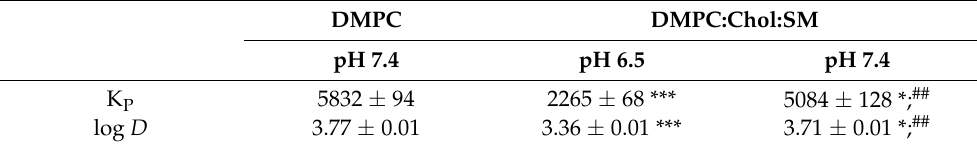
Figure 1. Steps for calculating the LUVs–buffer partition coefficient of BTZ. ( A ) UV–Vis spectra and ( B ) third-derivative spectra of BTZ (400 µ M) at increasing concentrations of DMPC:Chol:LUVs at 37 ◦ C and pH 6.5. The blank LUVs (control) spectra are presented in black, BTZ alone in green, and samples (BTZ incubated with increasing concentrations of LUVs) are shown in gray, with the higher concentration of LUVs presented in red. ( C ) Non-linear regression (Equation (1)) of the third derivative of experimental spectrophotometer data at λ = 278 nm for BTZ at different DMPC:Chol:SM LUVs concentrations (M). Non-linear regression (Equation (1)) of the third derivative of experimental spectrophotometer data at λ = 278 nm for BTZ at different ( D ) DMPC:Chol:SM (pH 7.4) and ( E ) DMPC (pH 7.4) concentrations (M). Table 1. Partition coefficients (K P ) and distribution coefficients (log D ) for BTZ in the studied a statistically significant difference when compared with DMPC LUVs (pH 7.4). ## p < 0.01 indicate a statistically significant difference when compared with DMPC:Chol:SM LUVs (pH